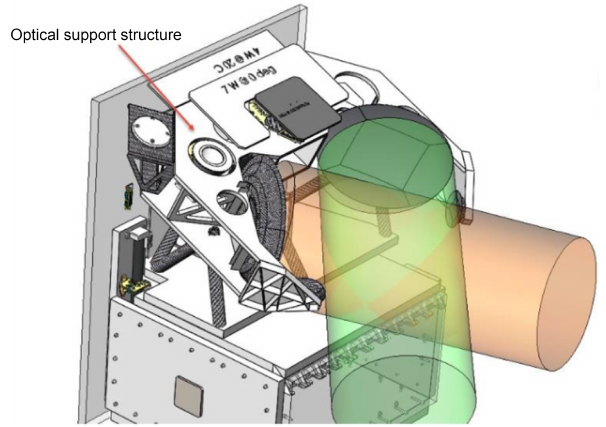
Figure 1. View of the InnoSat satellite. The box in the lower part is the platform service module. Above it is the scientific payload including the two antennas. The field of views are represented with green and beige colors (from Omnisys Instruments).